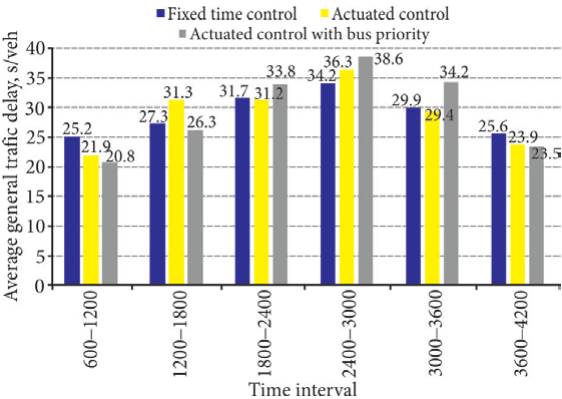
Fig. 10. Dynamics of average general traffic delay